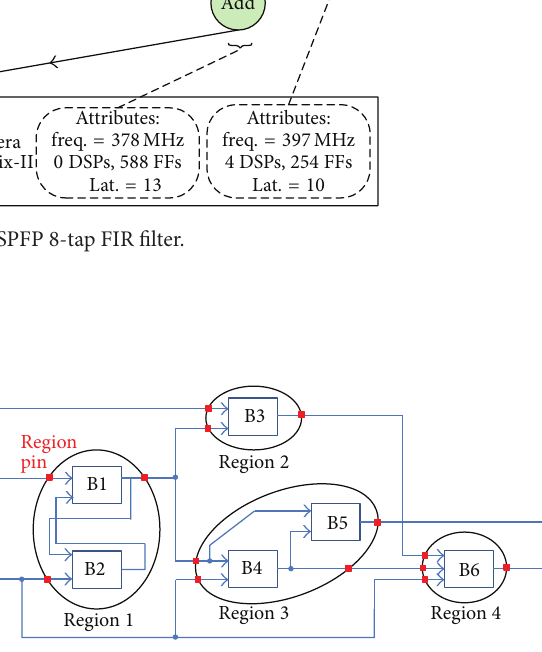
Figure 8: Example partition of a logic block diagram with 6 blocks